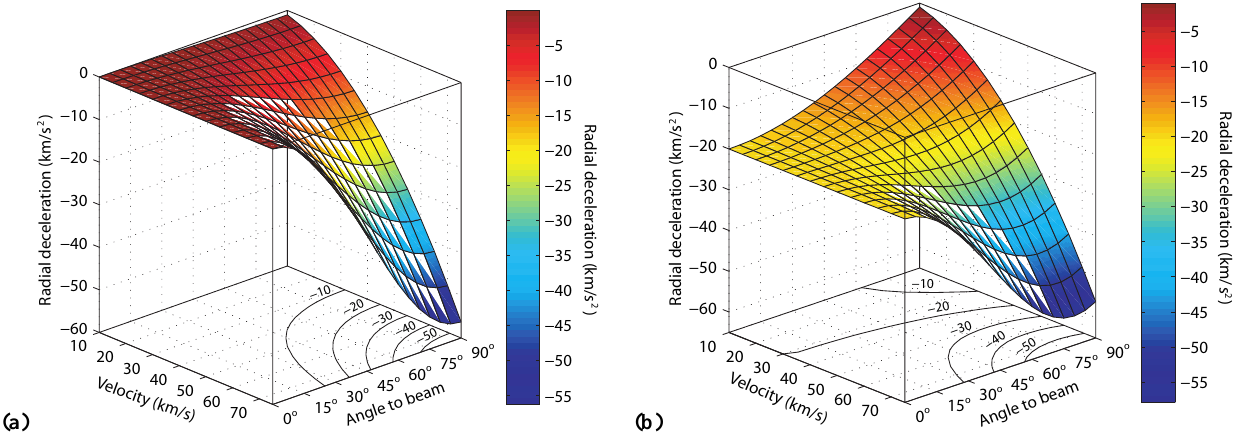
Fig. 12. Radial deceleration as a function of meteoroid velocity and angle from the trajectory to the beam (aspect angle) for (a) a non- decelerating meteoroid and (b) a meteoroid decelerating at − 20km/s 2 in the far-field at a range of 100km from a radar. The radial decelera- tion is estimated as a linear value by letting the beamwidth approach zero. The contours in the bottom of the charts are projected isolines of radial